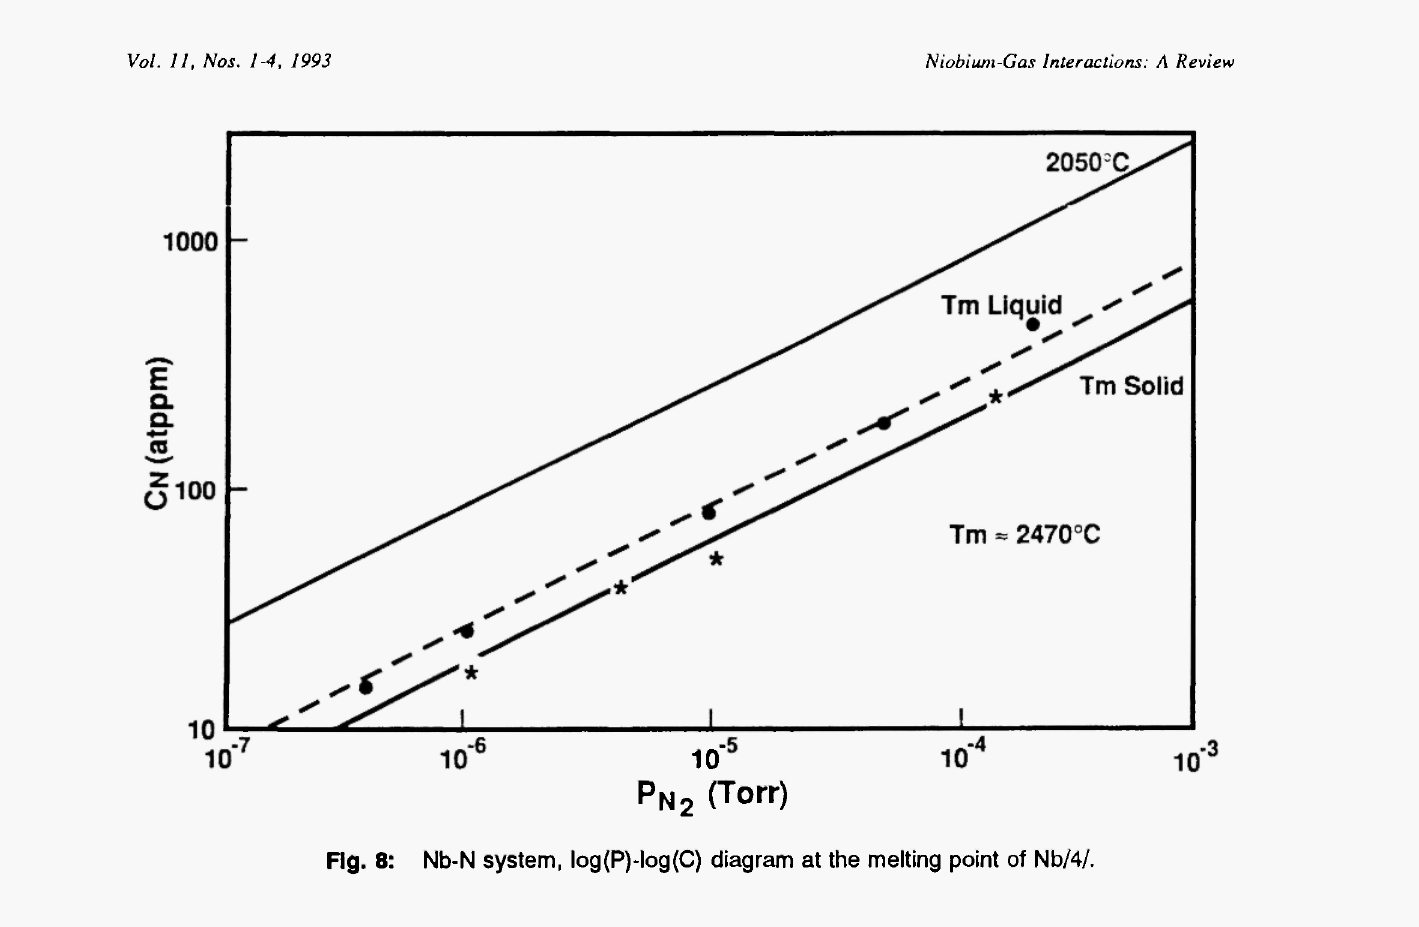
Fig. 8: Nb-N system, log(P)-log(C) diagram at the melting point of Nb/4/.